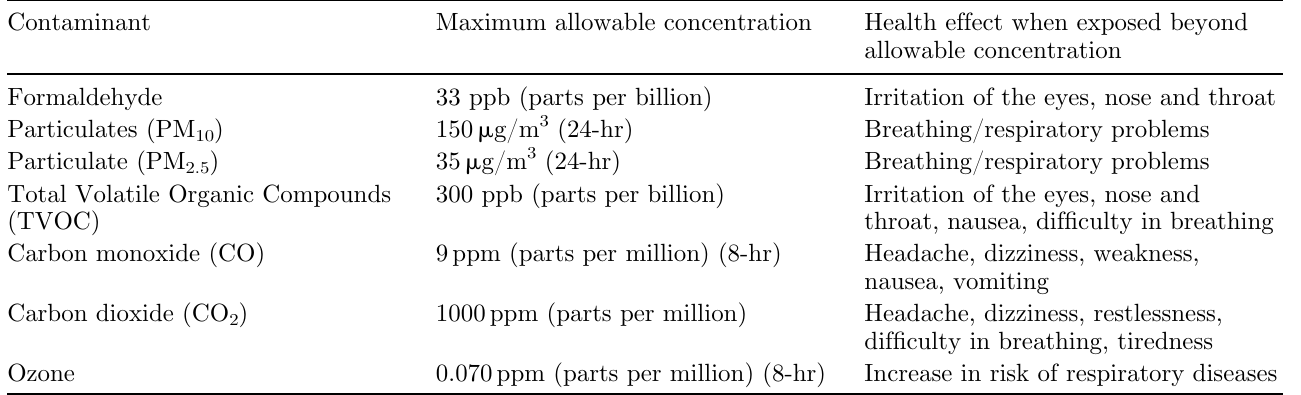
Table 2. Maximum allowable concentrations for some indoor air